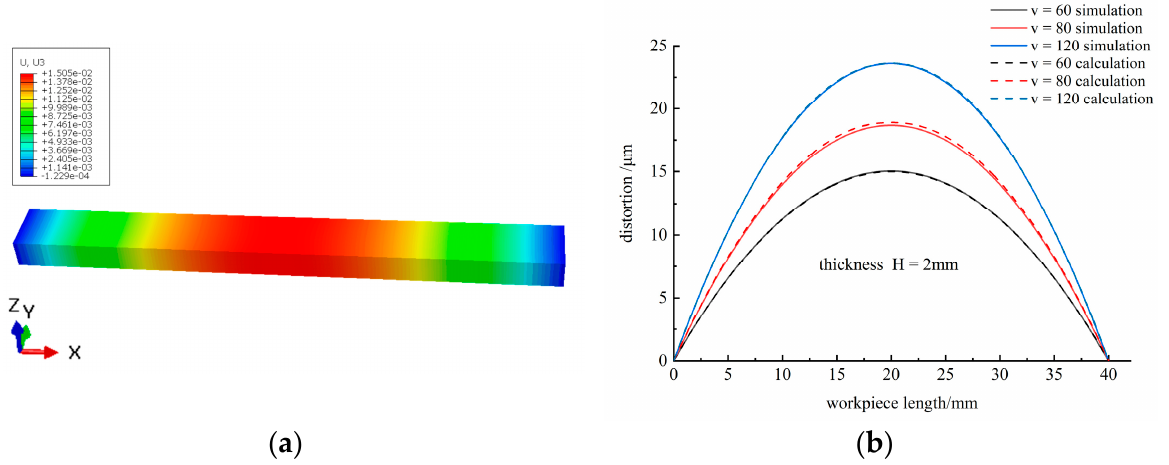
Figure 7. Influence of machining-induced residual stress on distortion. ( a ) results of workpiece distortion simulation; ( b ) simulation and calculation results.